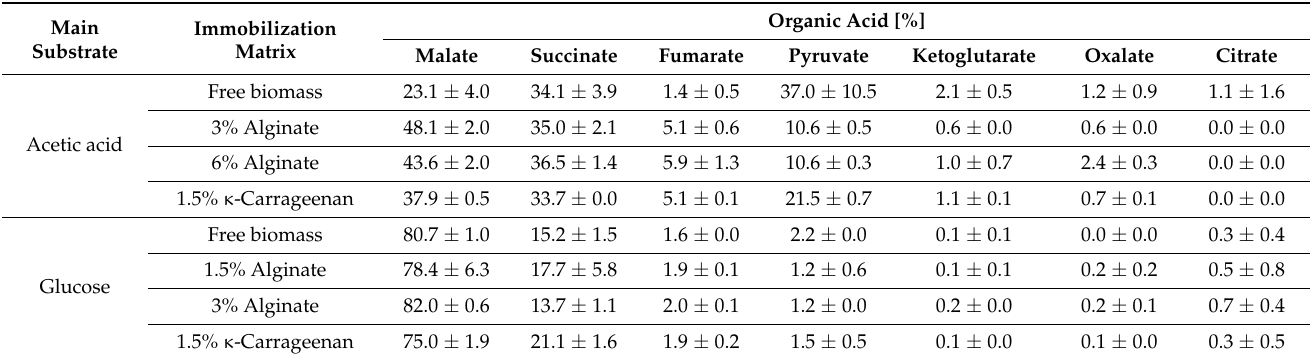
Table A2. Acid distribution for 2.5-L bioreactor cultivations of A. oryzae after 144 h. Values are means of duplicates with standard deviation.